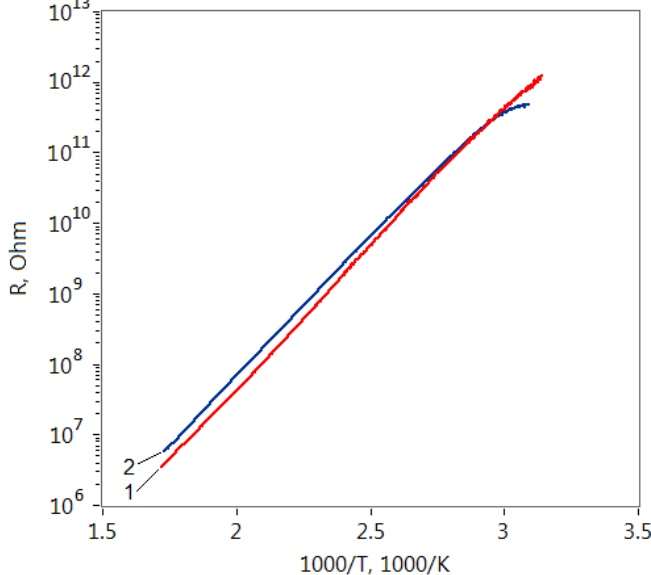
3 Figure 3. Resistance (R) dependences on reverse temperature (1000 / T) of ZnO–SnO Zn:Sn ratios: 1—99:1 and